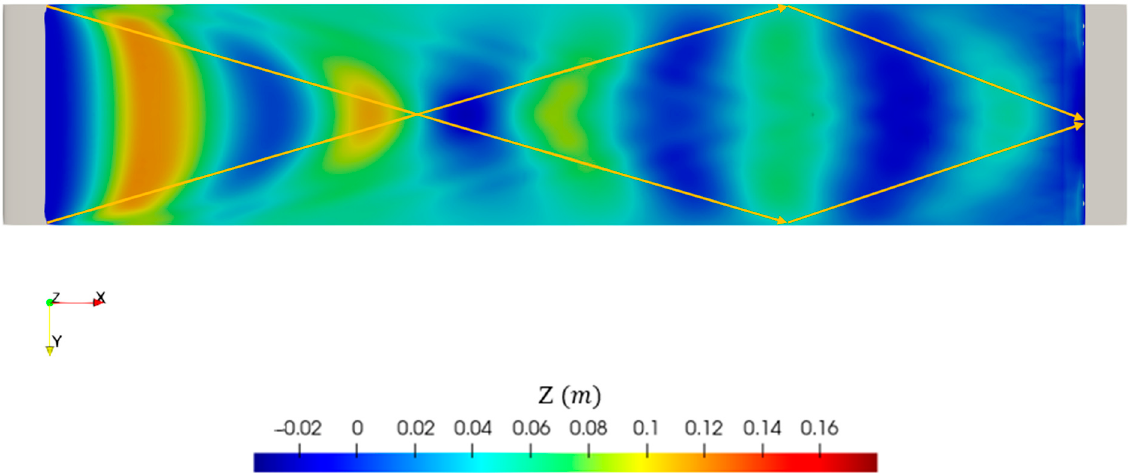
Figure 12. Air layer wave pattern in the bottom air cavity ( F r = 0.173, C q = 0.149 ).